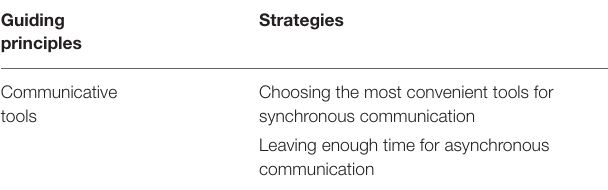
TABLE 2 | Strategies for social design. TABLE 3 | Strategies for technological